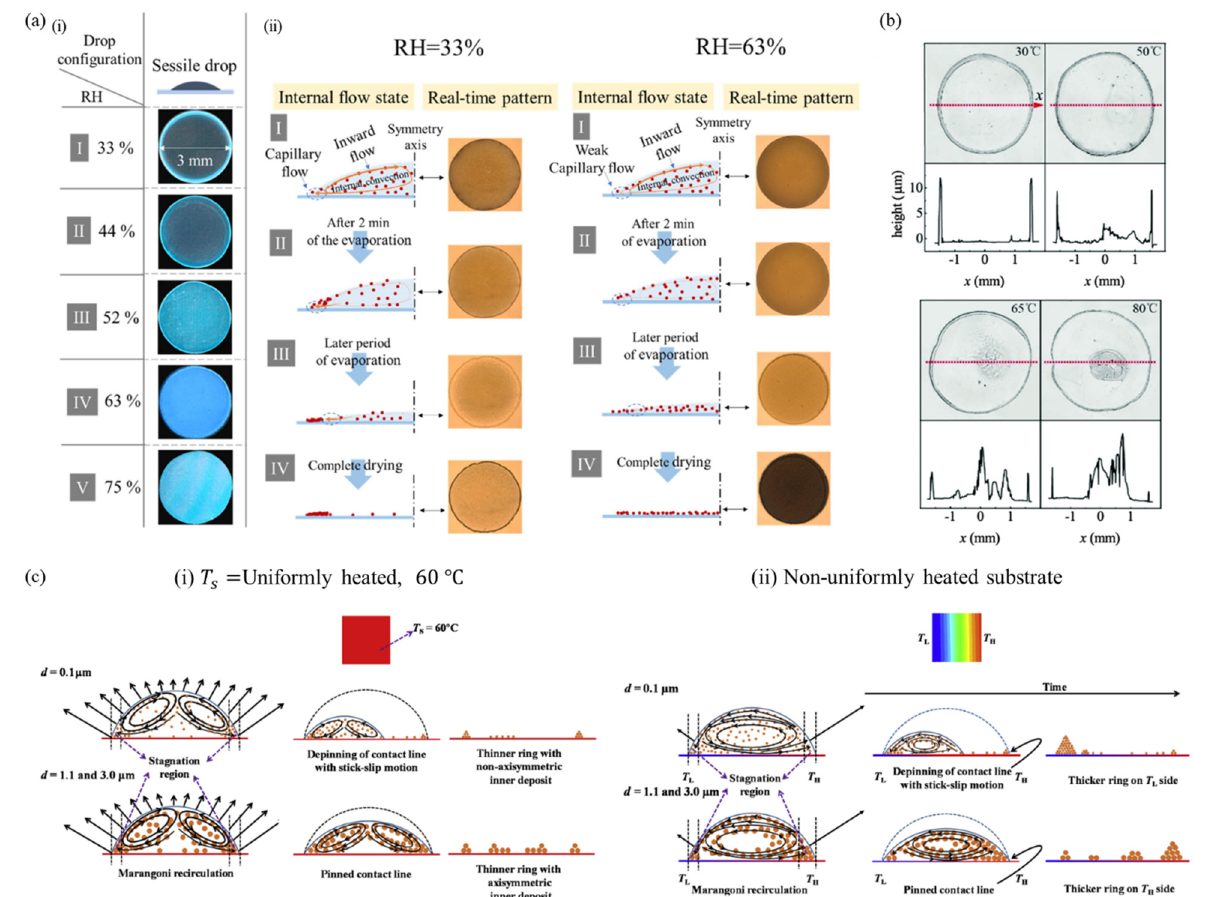
Figure 5. ( a ) (i) Dried patterns of sessile drops at various RH levels of 33%, 44%, 52%, 63% and 75%. (ii) Schematic migration processes of microspheres and real-time patterns during evaporation of the sessile drop under 33% and 63% (reproduced with permission from ref. [73]. Copyright 2022 Elsevier). ( b ) Final deposit pattern of water droplet containing PS particles of 100 nm as a function of the substrate temperature (reproduced with permission from ref. [78]. Copyright 2015 Royal